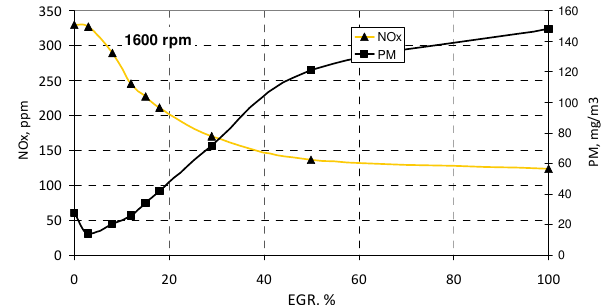
Fig. 17. Impact of EGR opening level at NO x and PM concentration (1600 rpm, 190 Nm)